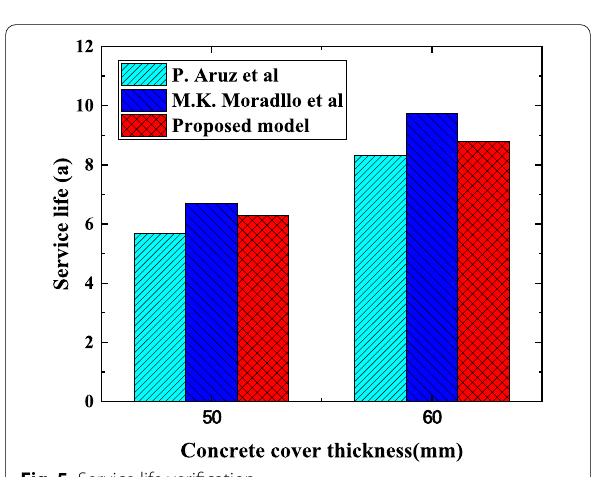
Fig. 5 Service life